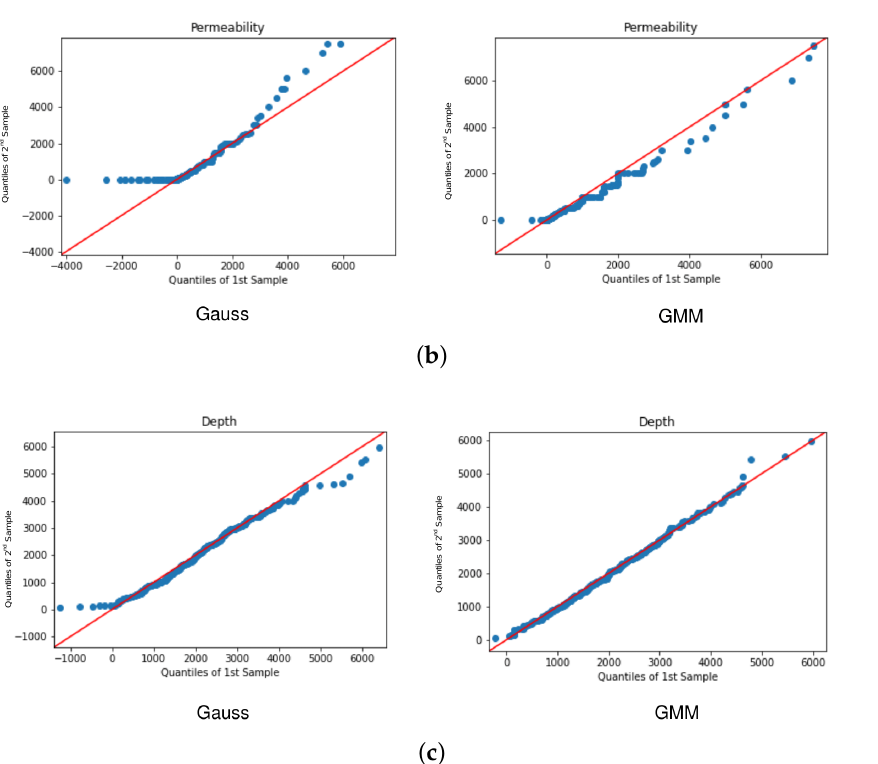
Figure 7. Comparison of distributions sampled from the network and original distributions for three continuous geological features for two training methods—based on the classical Gaussian distribution and based on the proposed mixture algorithm